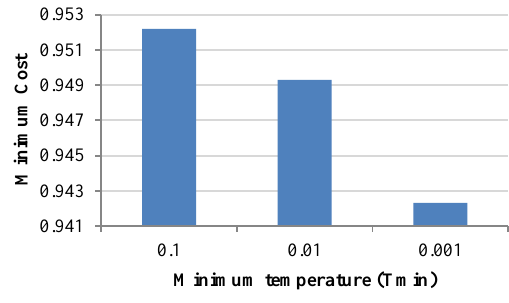
Figure 2. Effect of minimum temperature ( T min ) on the minimum cost of solutions.